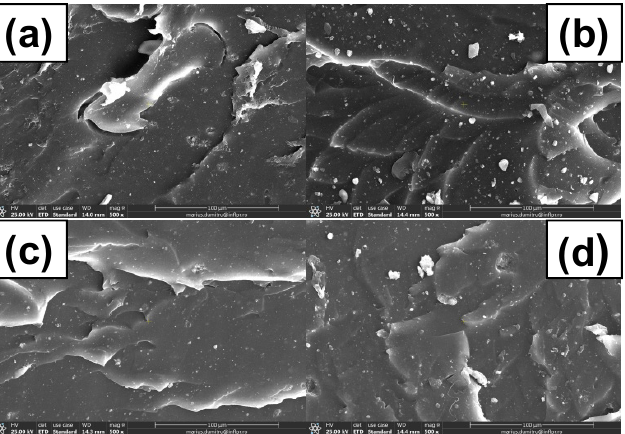
Figure 10. C0 SEM micrographs at magnification of 500: ( a ) un-irradiated, ( b ) irradiated at 150 kGy, ( c ) irradiated at 300 kGy, ( d ) irradiated at 450 kGy.